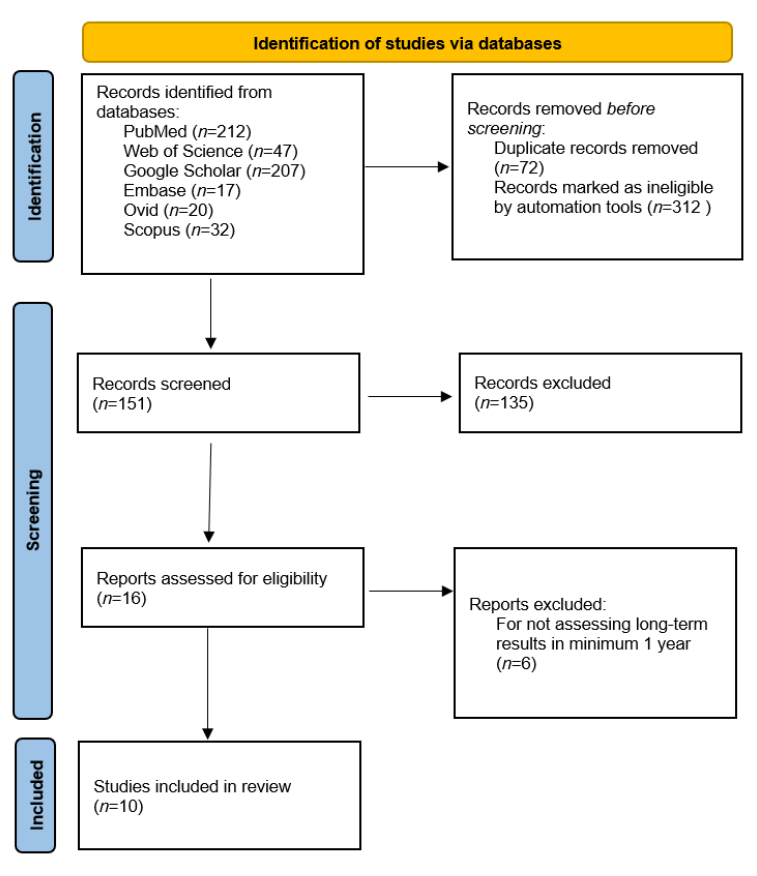
Figure 1. Flow diagram of the literature search.